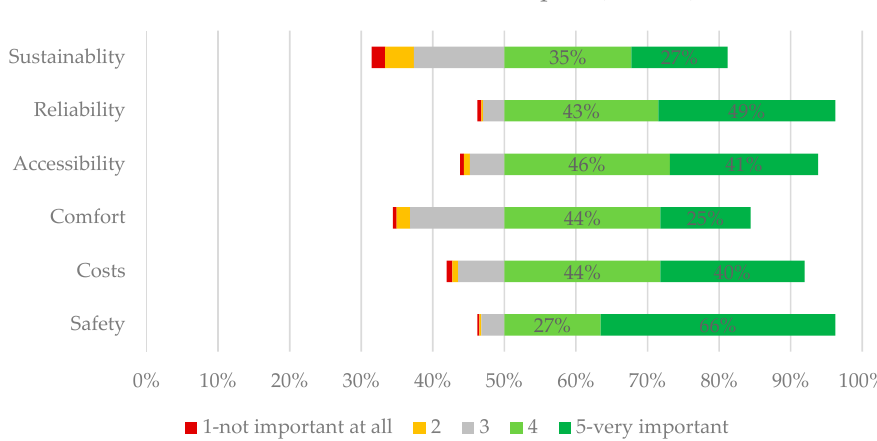
Figure 2. Important aspects of rail transport.